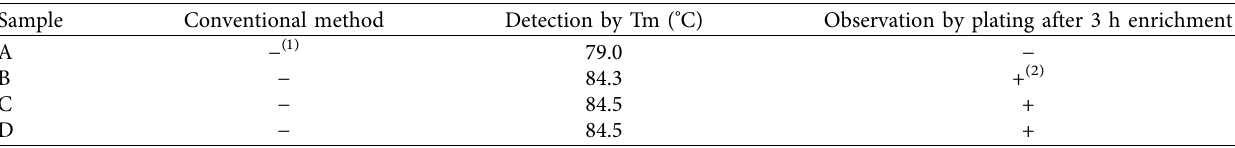
Table 2: Detection of the Listeria monocytogenes in the samples, which showed a negative or positive results in the conventional method Tm